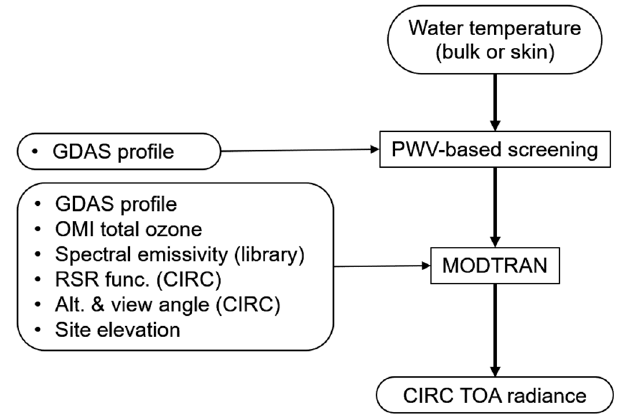
Figure 8. Processing flow of the TOA radiance estimation in Tel-VC.